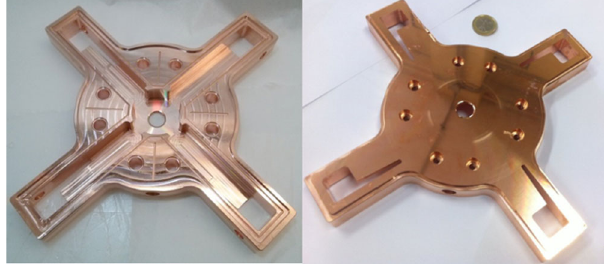
FIG. 3. Pictures of a fabricated cell.